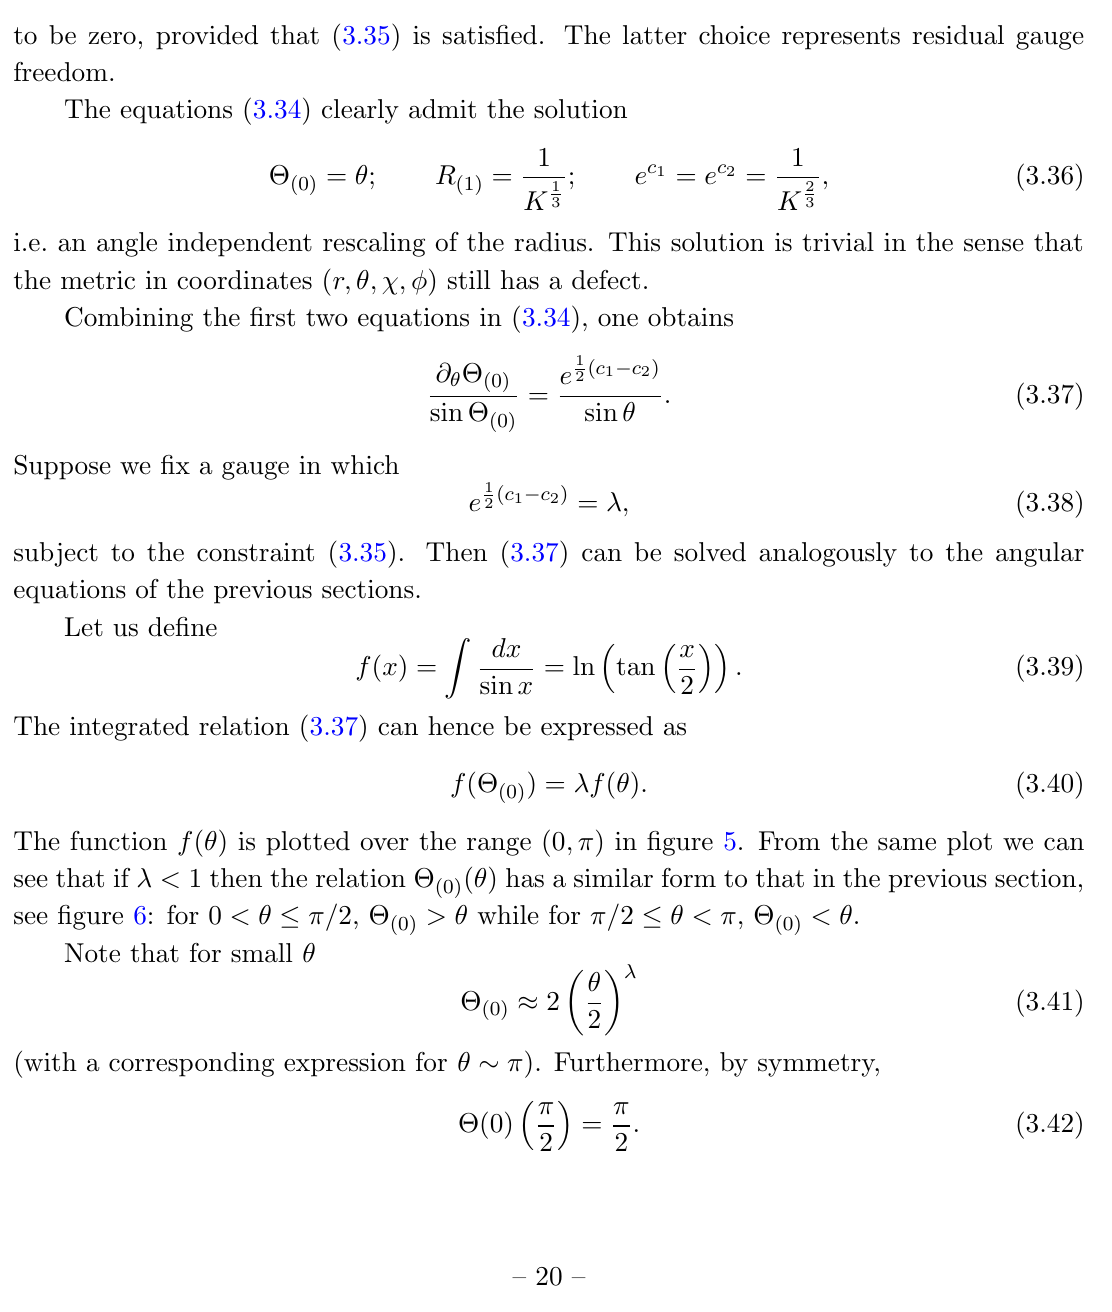
Figure 5 . The red line plots f ( (cid:18) ) and the blue line plots (cid:21)f ( (cid:18) ) for (cid:21) = 0 : 8. For any value of (cid:21) < 1 the blue curve will lie closer to the horizontal axis than the red